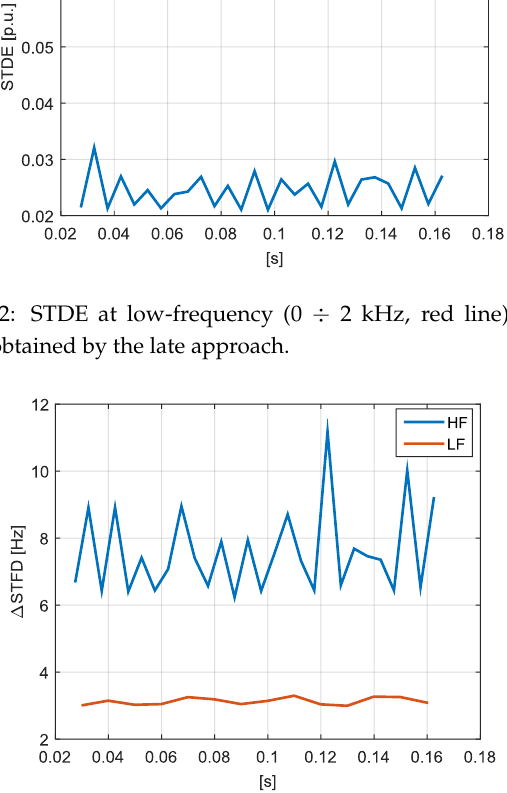
Figure 16. Case study 2: Δ STFD at low-frequency (0 ÷ 2 kHz, red line) and at high-frequency (2 ÷ 150 kHz, blue line) obtained by the late approach.